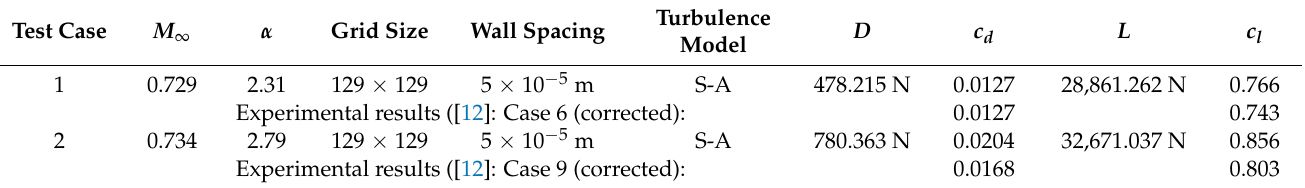
Table 1. Numerical simulation of transonic turbulent flow over the RAE 2822 airfoil using the software ANSYS Fluent. Test Case M